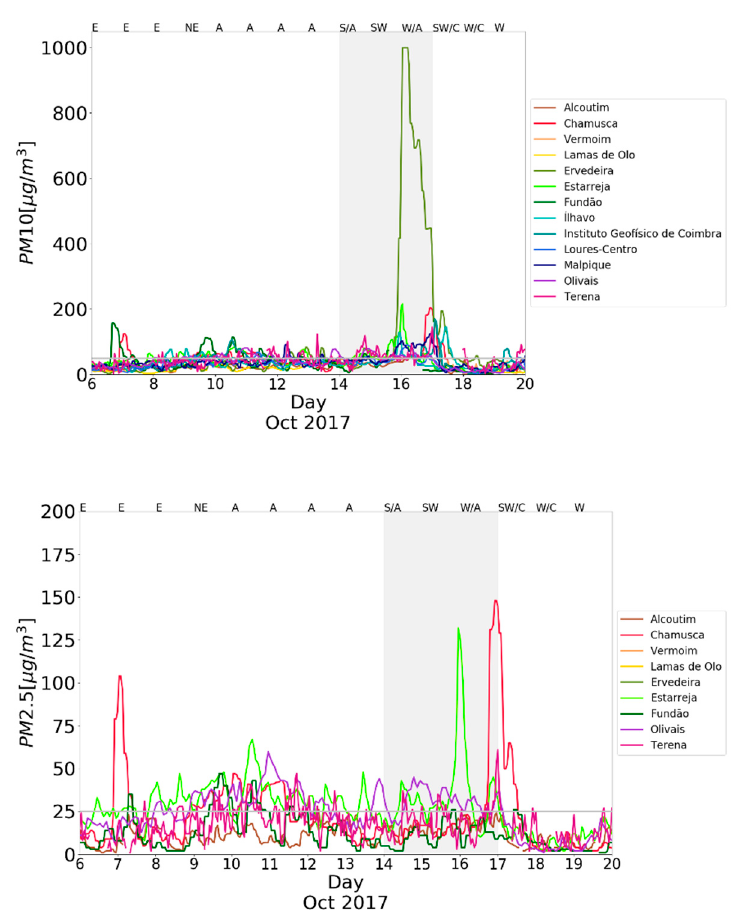
Figure 6. PM10 ( top ) and PM2.5 ( bottom ) hourly values observed at local monitoring stations over the period 6th–20th October 2017 (colored lines). Large fires occurred over 15th–17th October 2017 (grey area). The horizontal line depicts the PM10 and PM2.5 legal threshold values. The upper x-axis represents the prevailing CWT in each day.